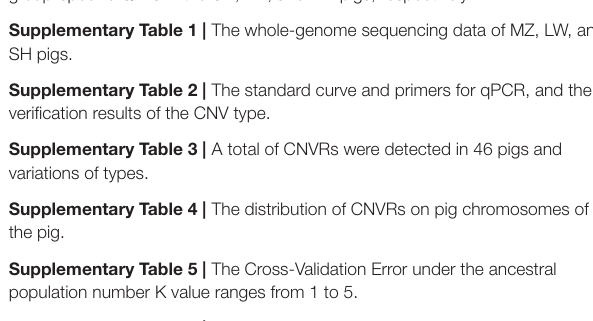
unique individual.